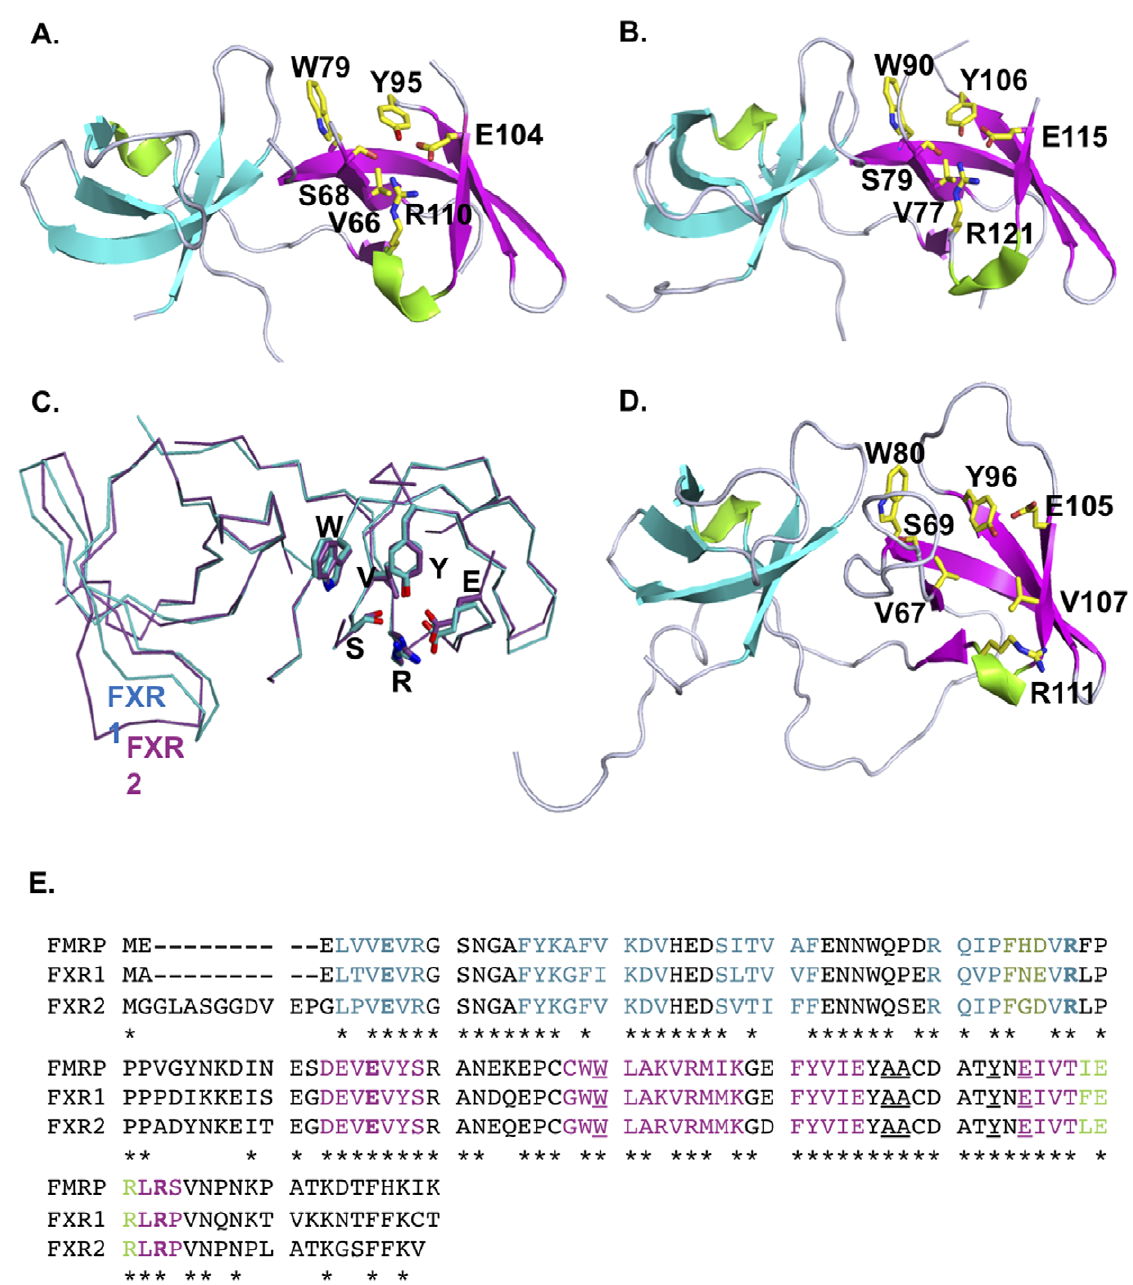
Figure 1. The crystal structures of FXR1 (A) and FXR2 (B) reveal a shared tandem Tudor domain architecture. Tud 1 domains are colored in cyan and Tud2 domains in magenta. Coiled regions are indicated in grey. The residues forming the aromatic cage of Tud2 are shown as in stick representation and are colored yellow. (C) FXR1 (cyan) and FXR2 (purple) align well and reveal a conserved interdomain orientation. (D The previously determined structure of FMRP (PDB 2BDK) also comprises the tandem Tudor architecture. The coloring is as described for the FXR1 and FXR2 panels. (E) The sequence alignment of the FXR proteins. Residues are colored in agreement with the b -strands of panels A, B, and D. Residues in bold correspond to the ionic lock, underlined residues exhibit alterations in the HSQC spectra on peptide titration, and the asterisks denote strictly conserved residues.